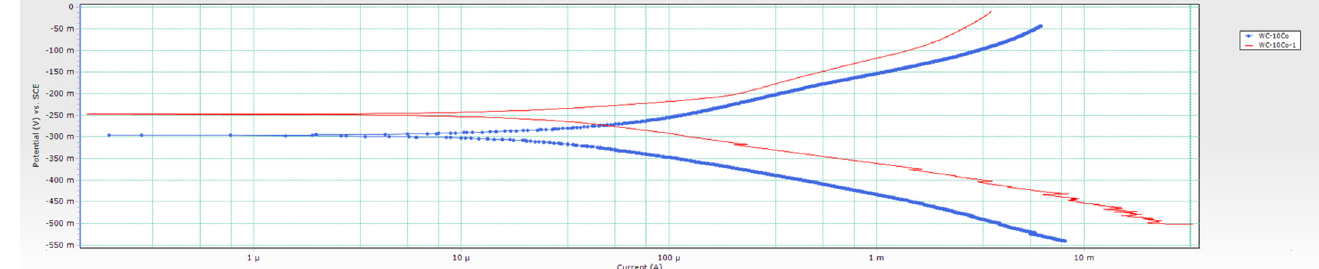
Figure 13. Tafel extrapolation curves of WC-10Co samples with different microstructural characteristics.